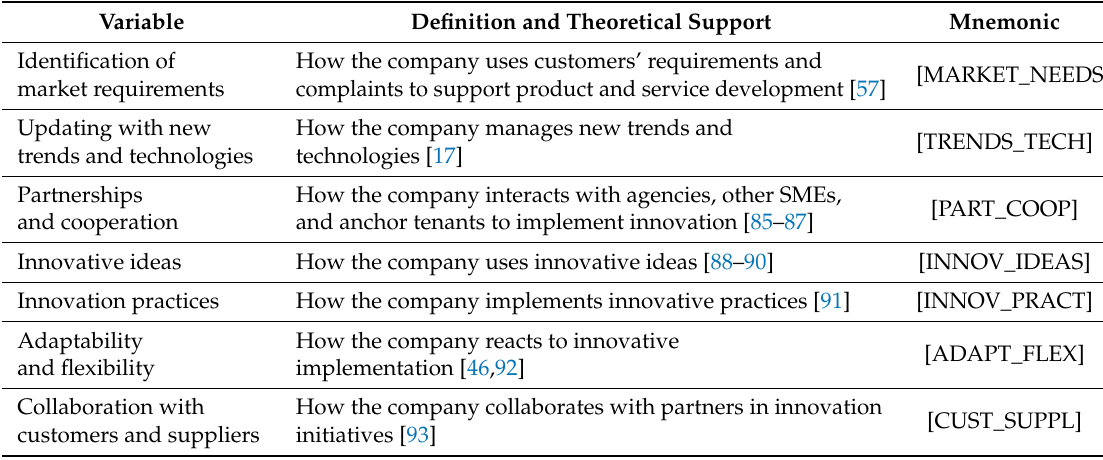
Table 1. Innovation